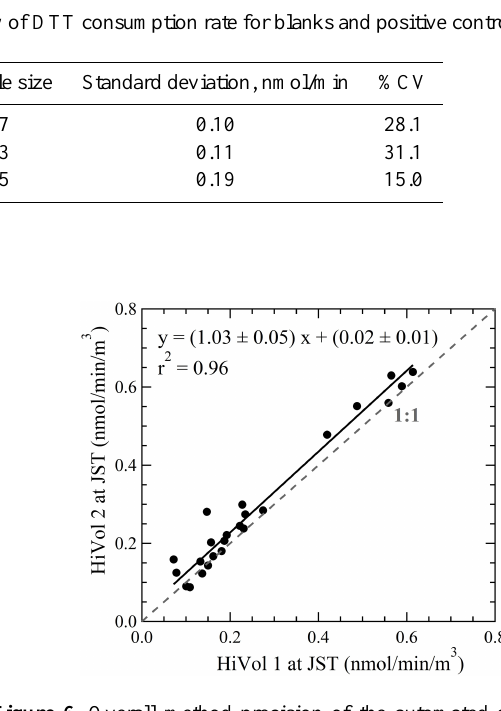
Figure 6. Overall method precision of the automated system as- sessed by PM 2 . 5 filter samples ( N = 24) collected simultaneously using two Hi-Vol samplers deployed side-by-side at JST during November 2012 and April 2013 (regression analysis was done by orthogonal regression; the dotted line is